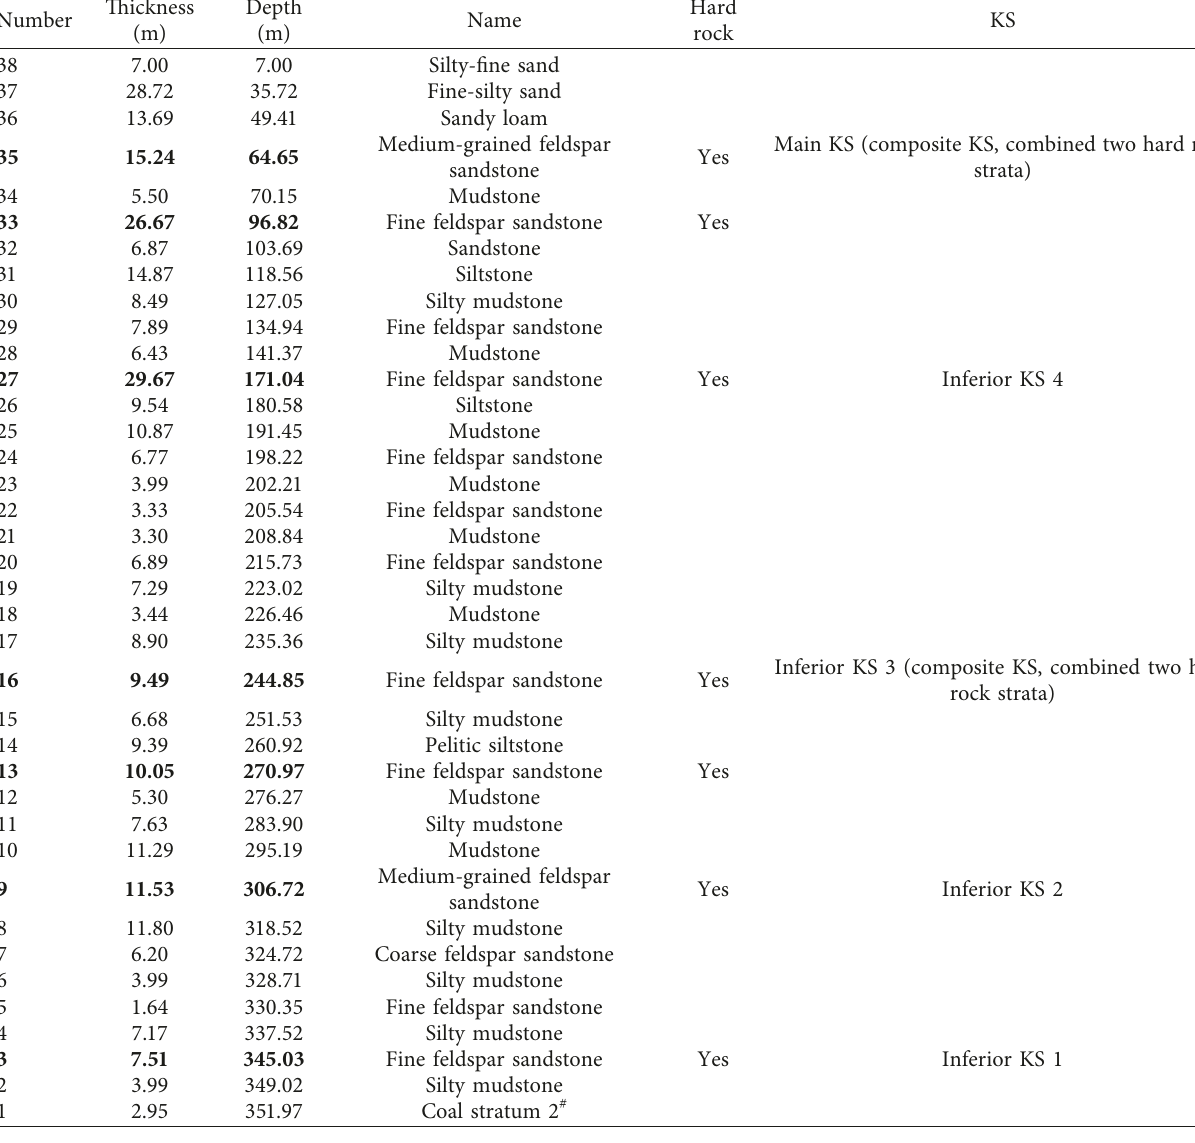
Table 2: Identification of the KS in working face 11203.